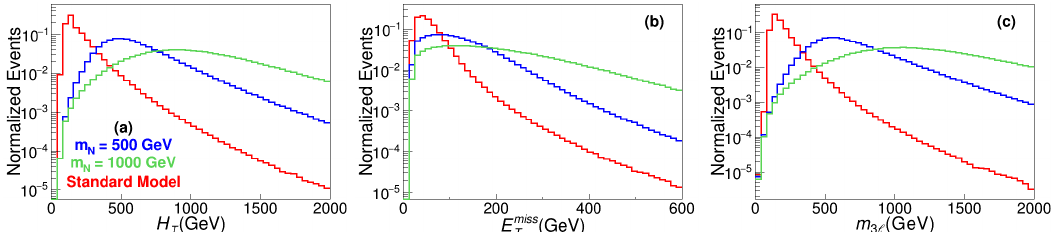
(middle) and m (right) of SM 3 ‘ T = 500 GeV (blue) and 1000 GeV (green) at N